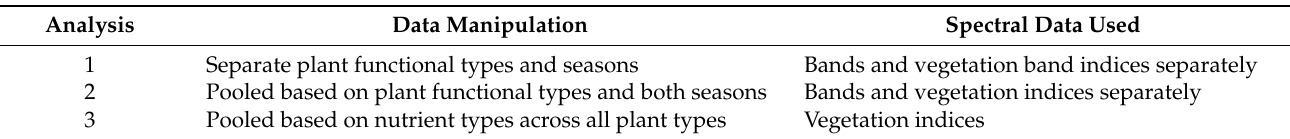
Table 3. Experiments were performed using S-2 MSI data to estimate macro and micronutrient concentrations in crops and wetland